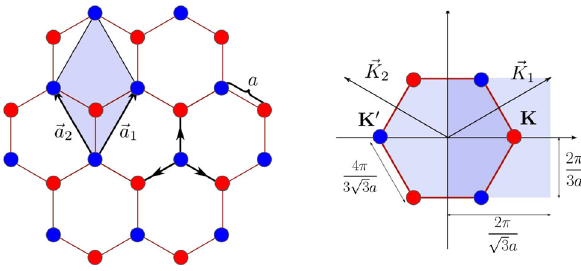
Fig. 1 Crystal structure of the honeycomb array of Weyl-Dirac mate- rials in real (left panel) and reciprocal (right panel) spaces. Primitive vectors are explained in the text. The interatomic distance is a